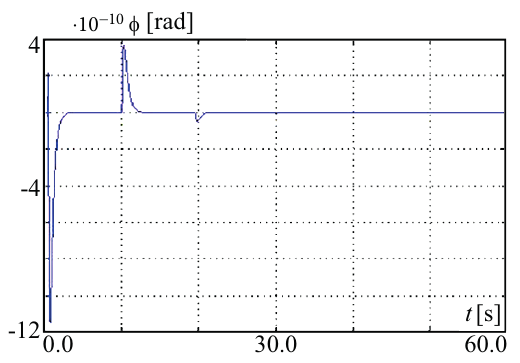
Fig. 15. Displacement along the OX -axis